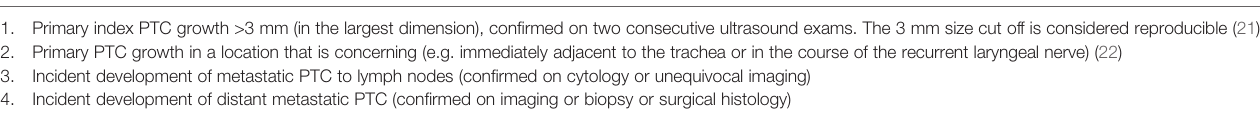
TABLE 2 | De fi nition of disease